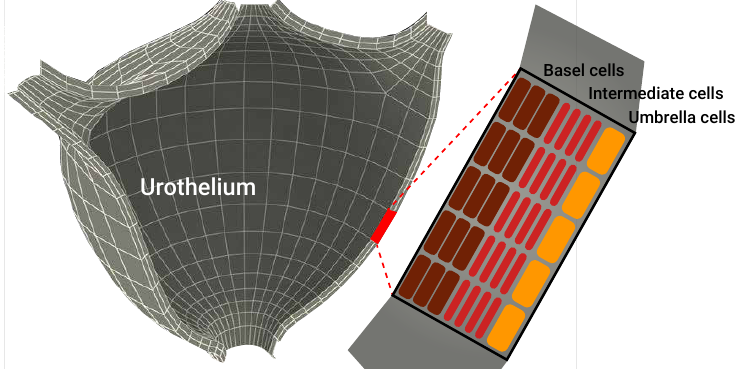
Figure 2. A schematic view of the geometrical configuration of the urothelium used in the model. The three-dimensional mesh configuration was adopted from [44]. In addition, the urothelium’s geometry is populated by eight layers of cells with a depth of 40 cells, following the model proposed by